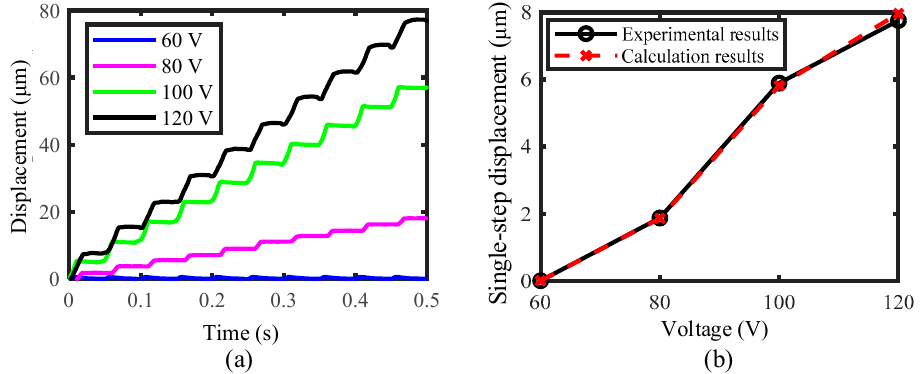
Figure 18. ( a ) Motion characteristics of the slider obtained under the critical relative gap and various driving voltages, and ( b ) single-step displacement changing with the voltage under the critical relative gap.